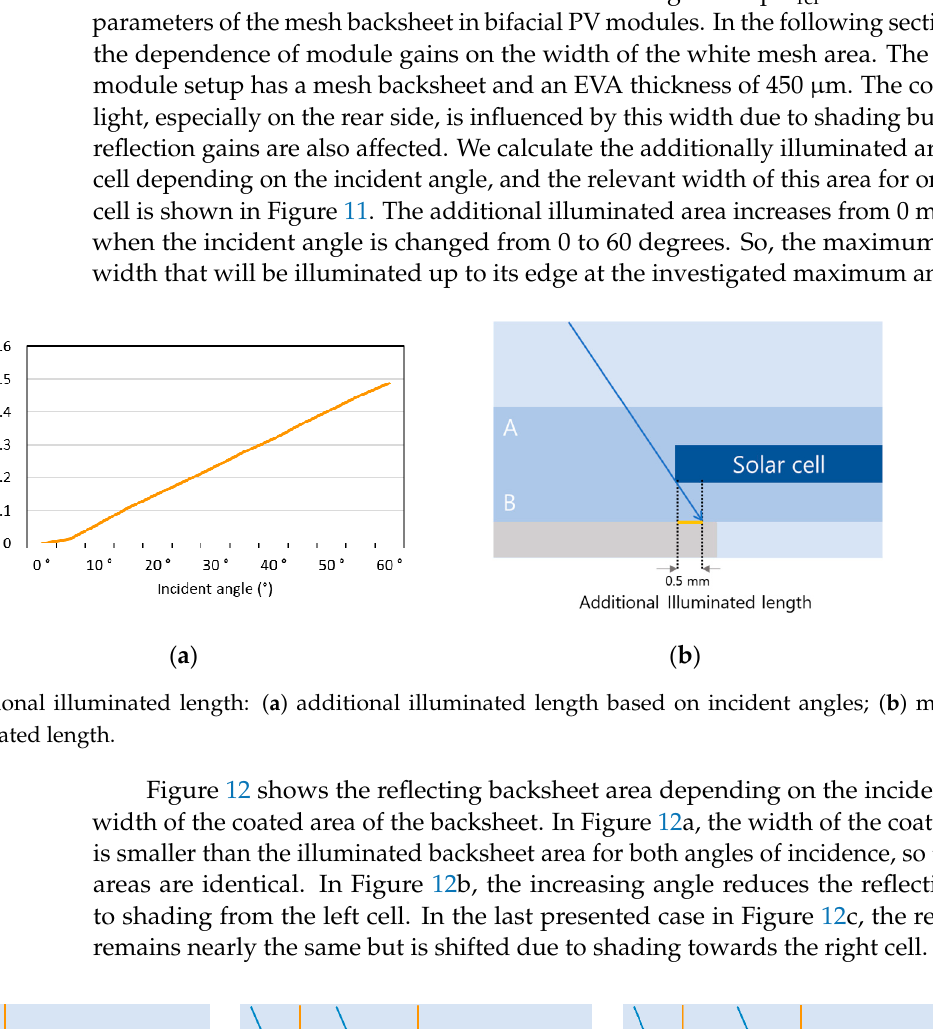
Figure 10. Power gain depending on bifaciality factor: ( a ) power gain due to internal reflection; ( b ) power gain due to rear side irradiance.